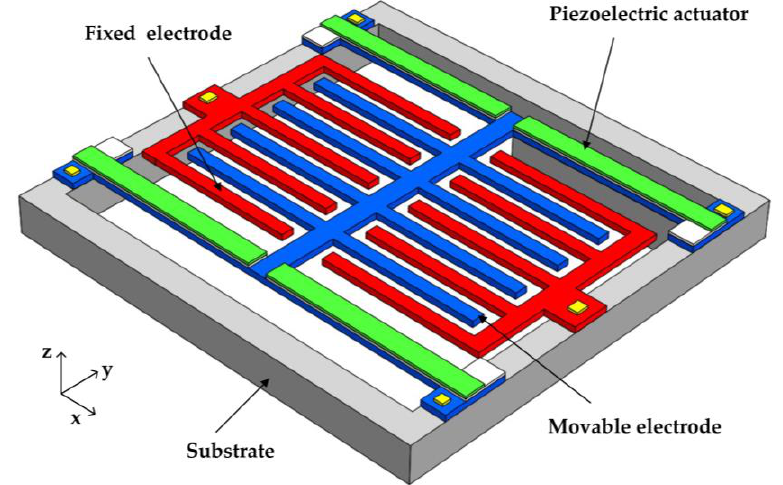
Figure 1. Schematic view of electric field microsensor (EFM) structure. Table 1. The key parameters of the proposed EFM. Structural